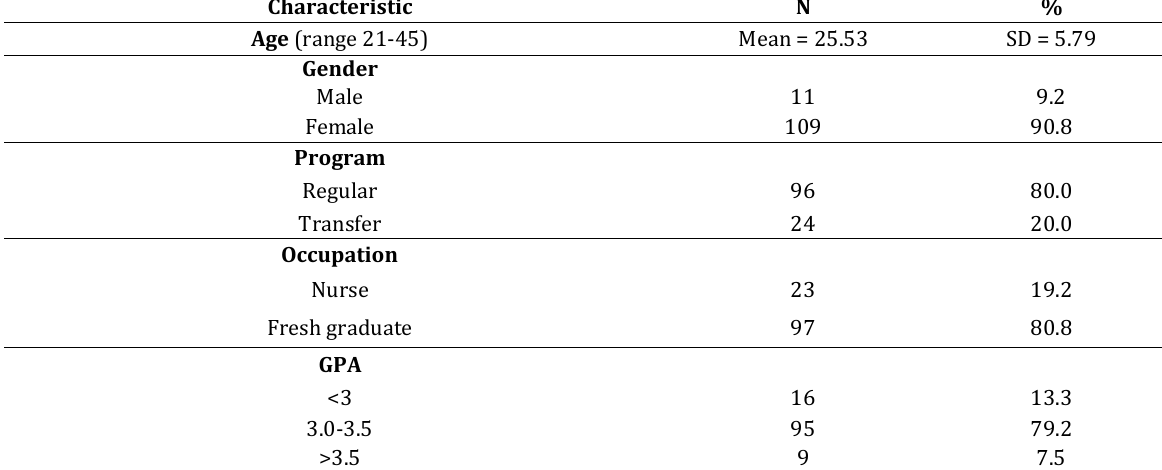
Table 1. Frequency, percentage, mean, and standard deviations of the patients' demographic data (n = 120)